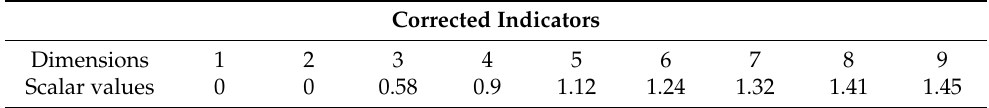
Table 3. Corrected